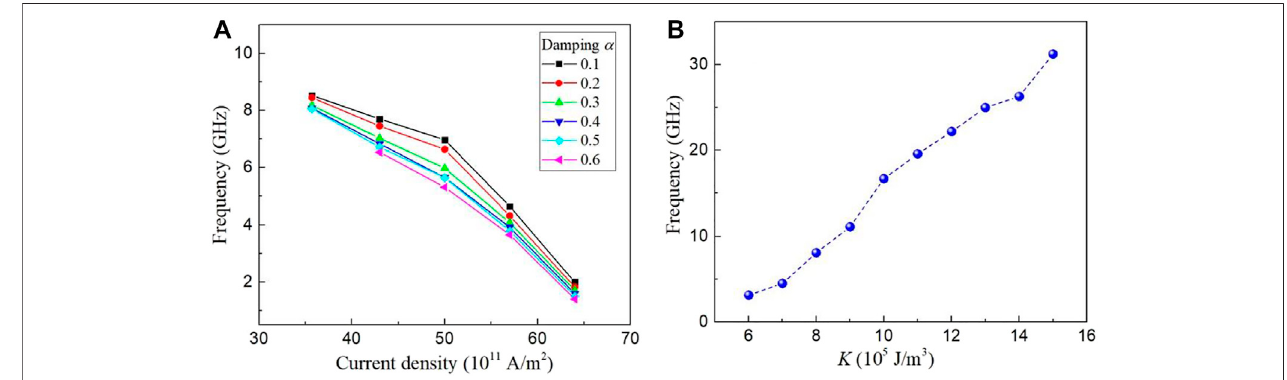
FIGURE 3 | (color online) (A) Dependence on the oscillation frequency of the applied current density and the damping α , where M S = 5.8 × 10 5 A/m, A = 1.5 × 10 − 11 J/m, K = 8.0 × 10 5 J/m 3 . DMI strength is 4.0 mJ/m 2 . (B) Dependence of the oscillation frequency on the anisotropy constant K , where the damping α = 0.5. The current density is fi xed to 36 × 10 11 A/m 2 .